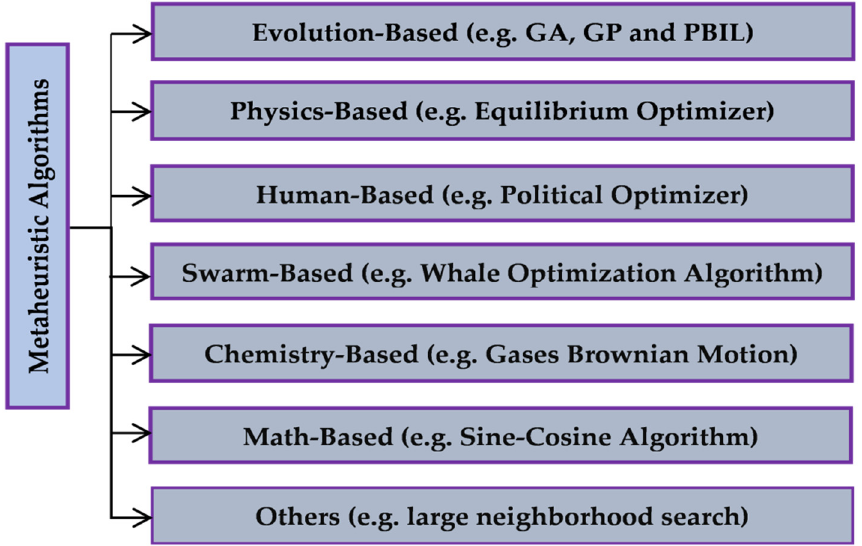
Figure 1. Categories of metaheuristic algorithms.